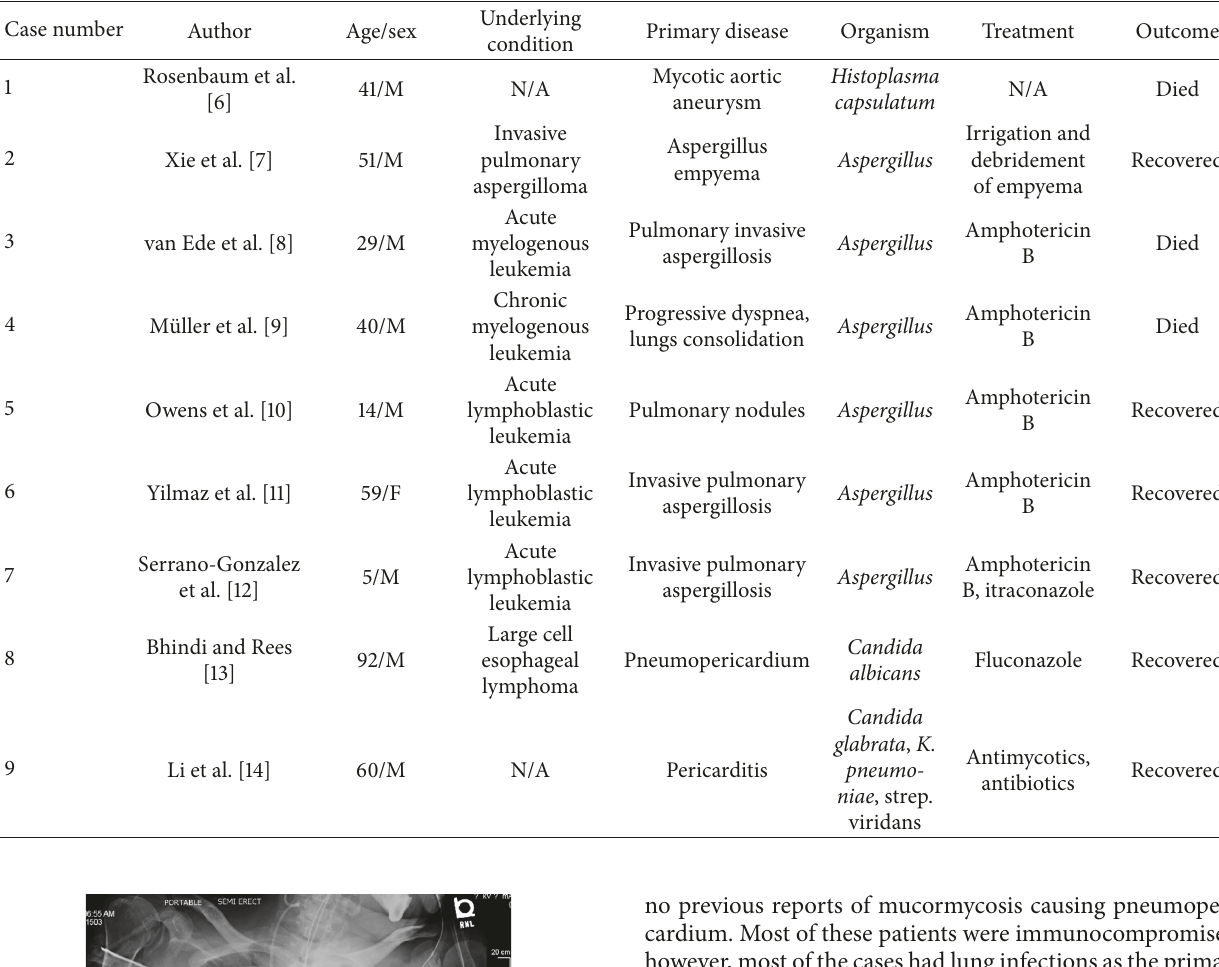
Table 1: Characteristic findings of previously reported cases of fungal pneumopericardium.